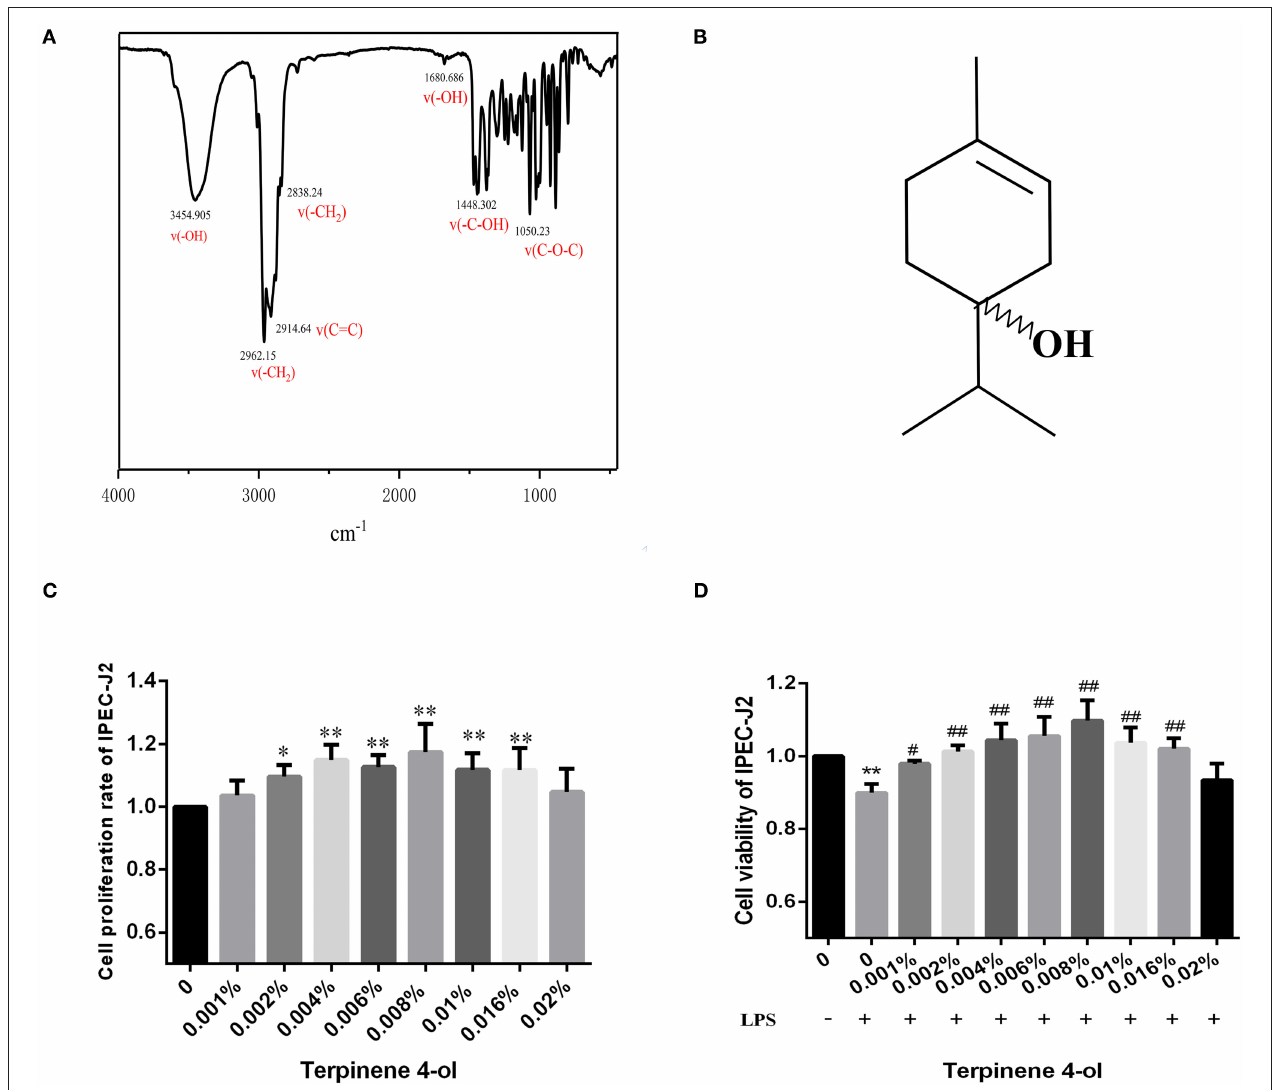
FIGURE 2 | The characterization of TER. (A) The infrared spectrum of TER. (B) The chemical structure of TER intestinal epithelial cells pretreated with different TER concentrations for 24h followed by treatment with LPS (10 µ g/mL) for 24h. The effects of TER on (B,C) cytotoxicity and (D) cell viability were observed in IPEC-J2 cells exposed to LPS. The data are expressed as the mean ± standard error of three independent experiments. * P < 0.05, ** P < 0.01, compared with the blank control group. # P < 0.05, ## P < 0.01, compared with the blank LPS group.